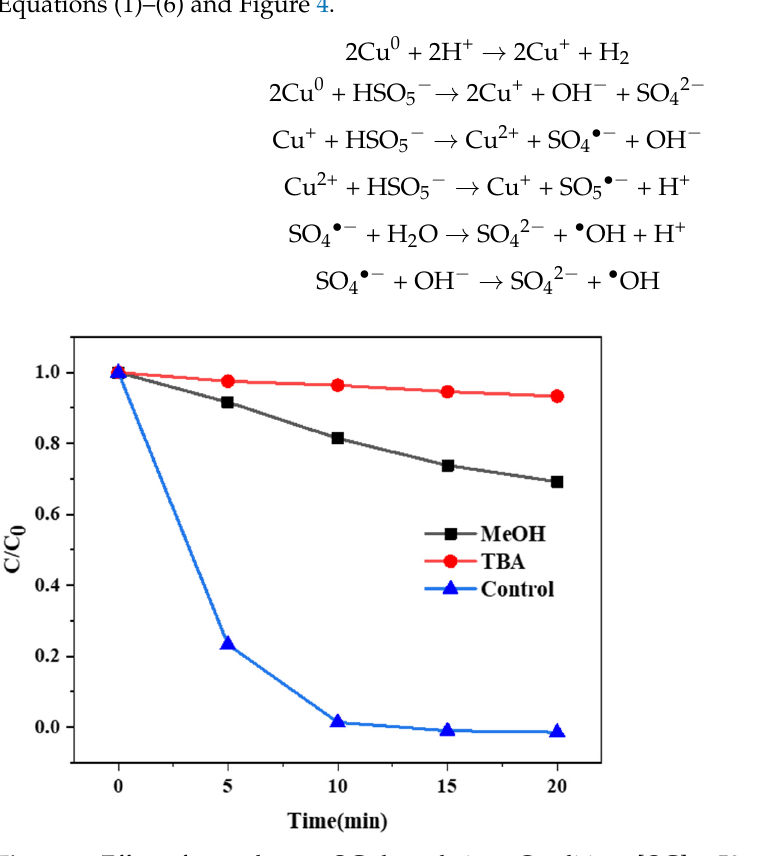
Figure 3. Effect of quencher on OG degradation. Condition: [OG] = 50 mg/L, [PMS] = 3 mM, [ZVC] = 0.3 g/L, [MeOH] = [TBA] = 200 mM.